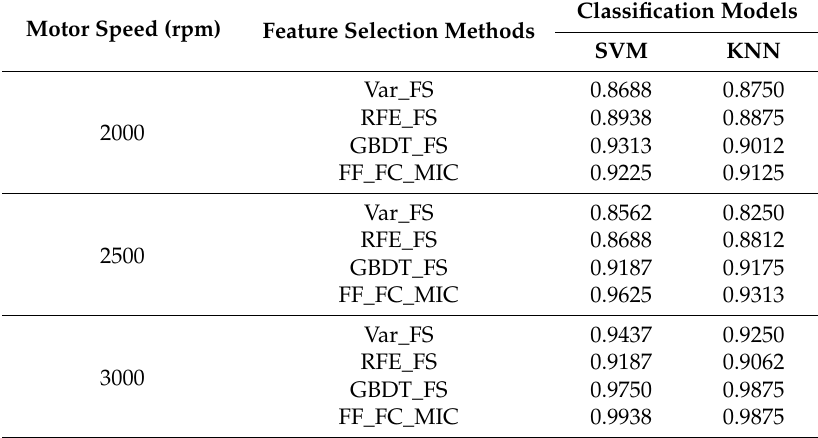
Table 7. Comparison of classification accuracy of SVM and KNN at motor speeds of 2000 rpm, 2500 rpm and 3000 rpm using different feature selection methods.